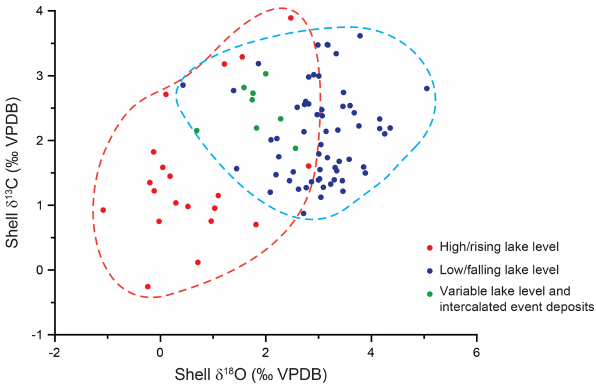
Figure 7. Ahlat Ridge L. inopinata δ 18 O vs. δ 13 C values, colour coded according to the lithology of their respective sampling hori- zon. Lithologies are colour coded according to their genetic inter- pretations related to lake level variability following Stockhecke et al.